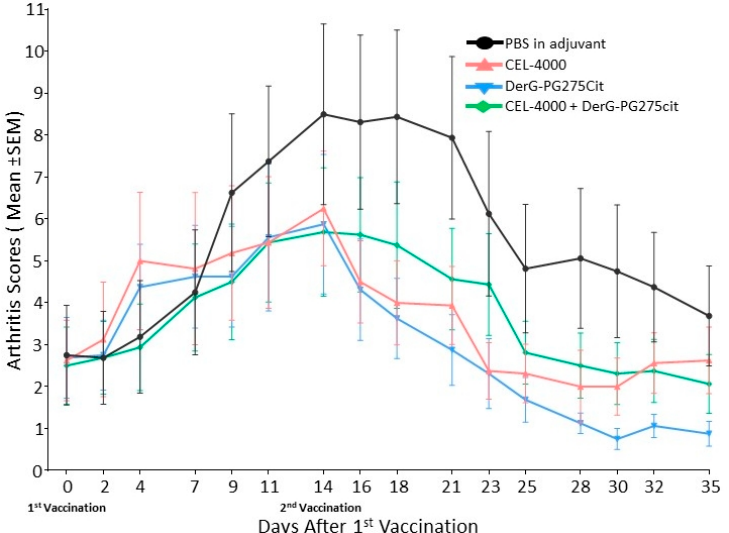
Figure 2. Therapeutic effects of LEAPS vaccine treatment on arthritis in GIA mice in the introductory study (study 1). LEAPS therapy was initiated in the GIA mice on days 0 and 14 after the onset of arthritis (visual arthritis score ~3 in each group, n = 8 mice per group). All treatments were administered in adjuvant. Arthritis severity was assessed by visual scoring 3 times a week for 5 weeks. The treatment groups were as follows: PBS in adjuvant (adjuvant control) represented in black; LEAPS conjugate DerG-PG70 (CEL-4000), represented in red; LEAPS conjugate DerG-PG275Cit, represented in blue; Combination of CEL-4000 and DerG-PG275Cit, represented in green. Disease severity was significantly suppressed (reduced arthritis score) in mice treated with LEAPS vaccines as compared with the adjuvant-treated control group. The 2-way repeated measures ANOVA was used for statistical analysis (see Supplemental Table S1 for p values of visual arthritis scores and other details).